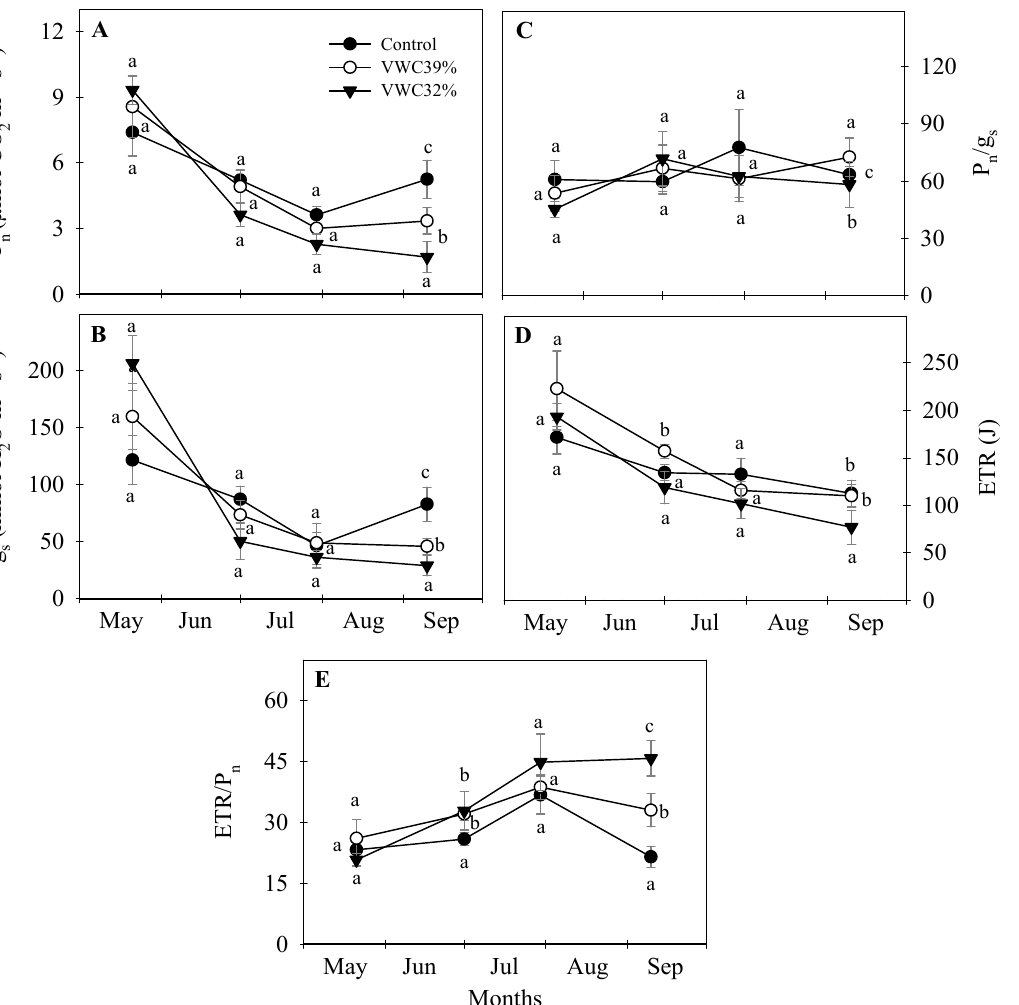
Figure 5. Time evolution of net photosynthesis at midday (P n ) ( A ), stomatal conductance at midday (g s ) ( B ), P n /g s ratio ( C ), ETR ( D ), and ETR/P n ratio ( E ). Control (black), VWC39% (light gray), and VWC32% (dark gray) denote Hebe plants grown at 49.28%, 38.44%, and 32.16% VWC, respectively. Values are means ( n = 5) and vertical bars show ± standard error. Different letters indicate statisti- cally significant differences between means at p < 0.05 according to the least significant difference (LSD) test.